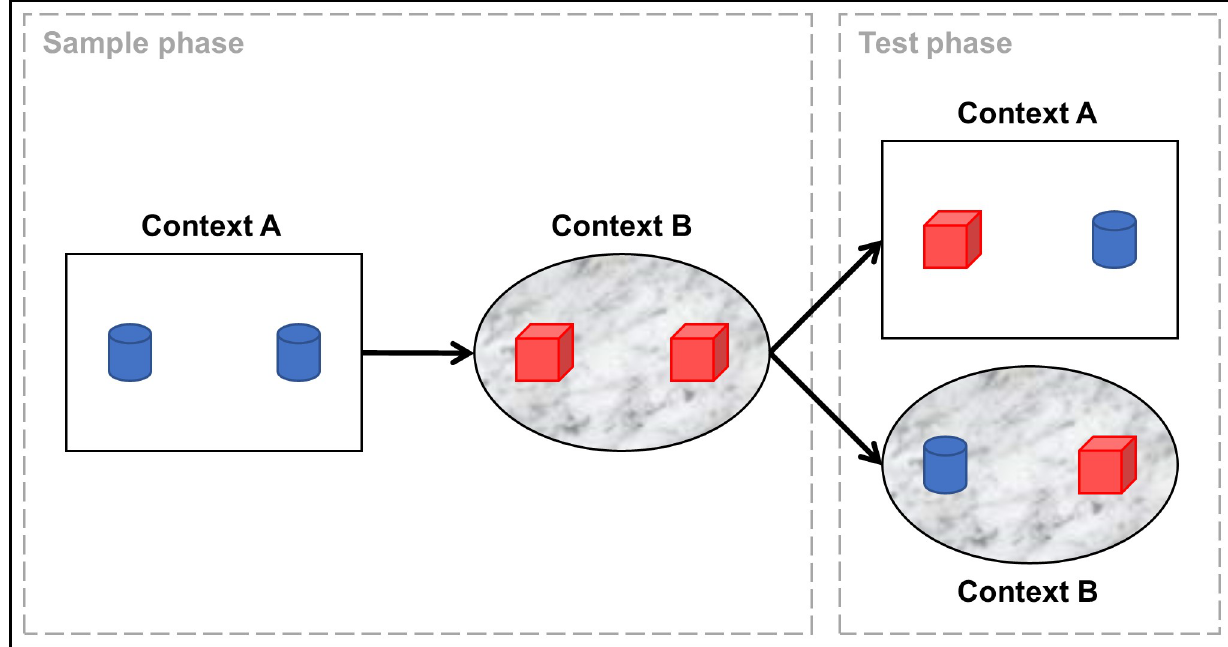
Fig 1. Schematic overview of the rodent object-in-context task (OIC). During the sample phase (learning) an animal encounters a unique set of two objects in context A and next a different set in B. In the test phase (memory) the animal is exposed to either context A or B, with one object of each unique